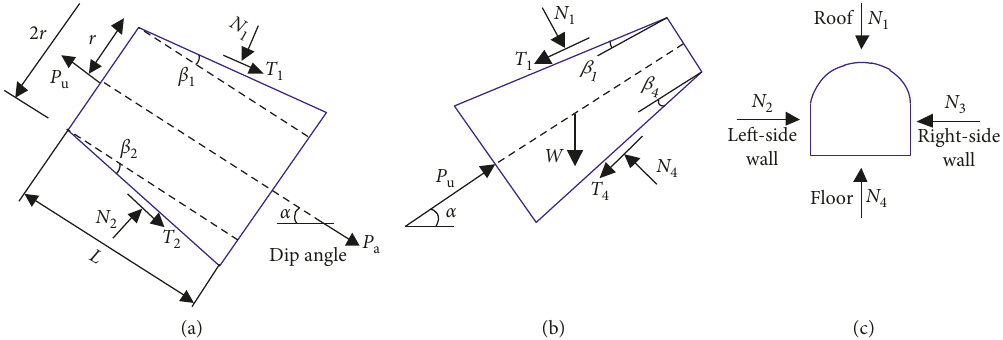
Figure 9: The calculation model of the of ultimate pullout force of TTAs with interface failure mode. (a) Wang [51, 57] and (b) Jiang [46].